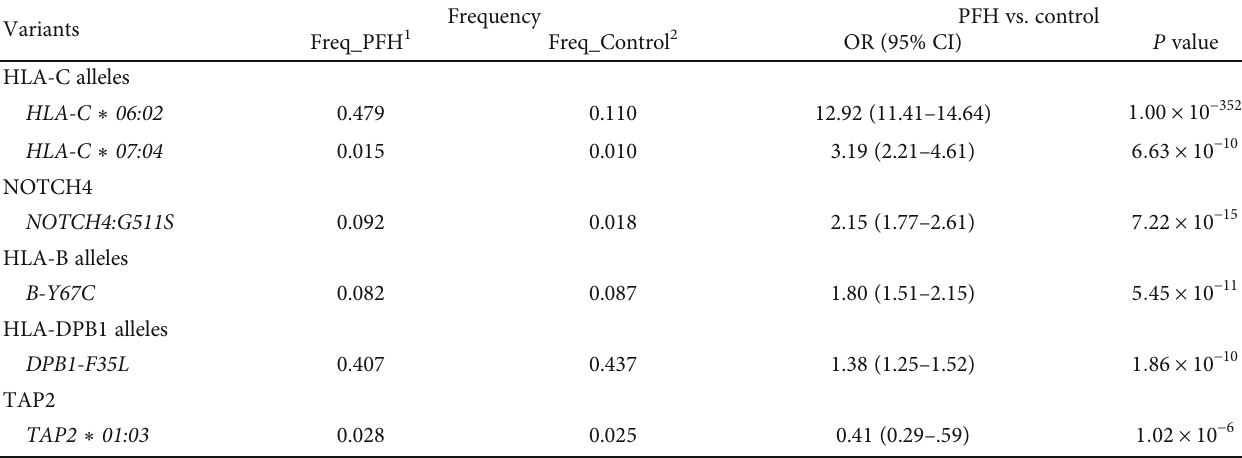
Table 2: Association of variants with psoriasis with a family history (PFH) in the multivariate regression